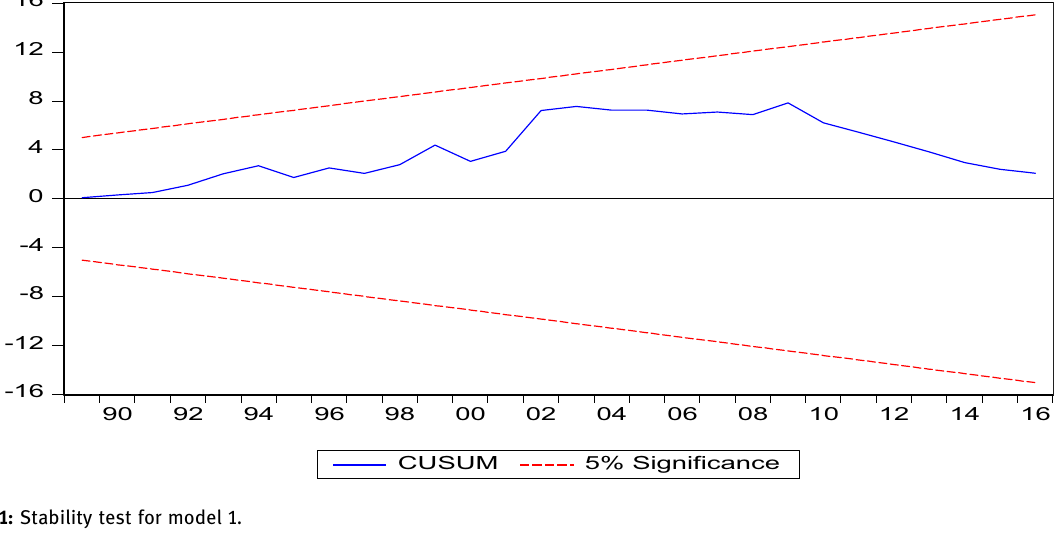
Figure A1: Stability test for model 1.